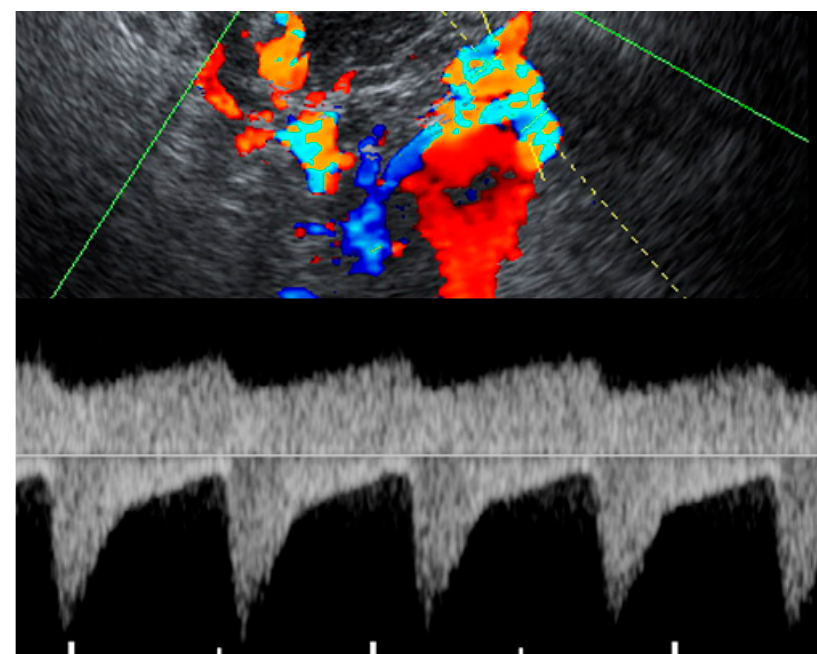
Figure 2. and Video S2 : A color flow ultrasound of the same mass as Figure 1 shows swirling flow in the mass, which is consistent with the arterial flow as presented in Figure 2 and video S2. A uterine artery aneurysm was diagnosed based on the finding of active swirling blood flow in the saccular-like sac connecting the uterine artery.